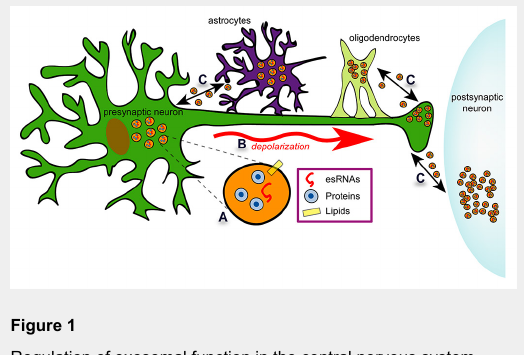
Regulation of exosomal function in the central nervous system. Black circles represent exosomes whose functions can be regulated in ( A ) intracellular cargo sorting; ( B ) space-time regulation of secretion; ( C ) cellular target specificity. esRNA = exosomal shuttle